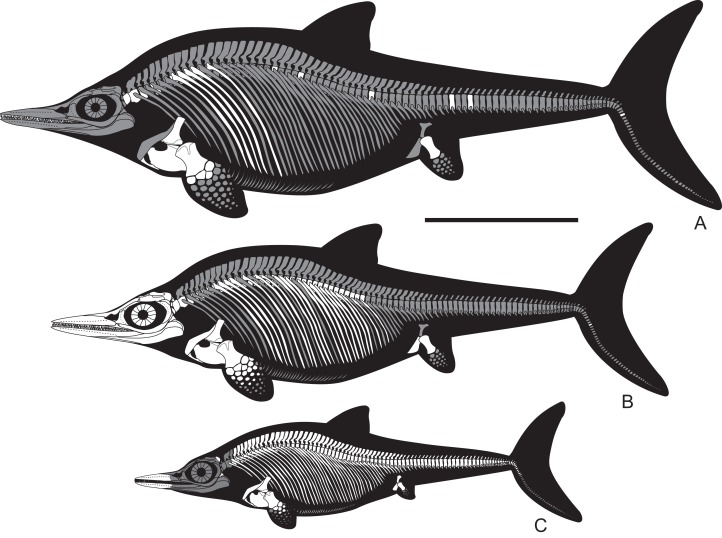
Skeletal reconstructions of Arthropterygius chrisorum old adult based on CMN 40608 and SGM 1573 (A) young adult based on CCMGE 17–44/13328 and PMO 222.669 (B), and juvenile based on CCMGE 3–16/13328 and PMO 222.655 (C).Unknown skeletal regions are shown in gray. Scale bar equals one m.